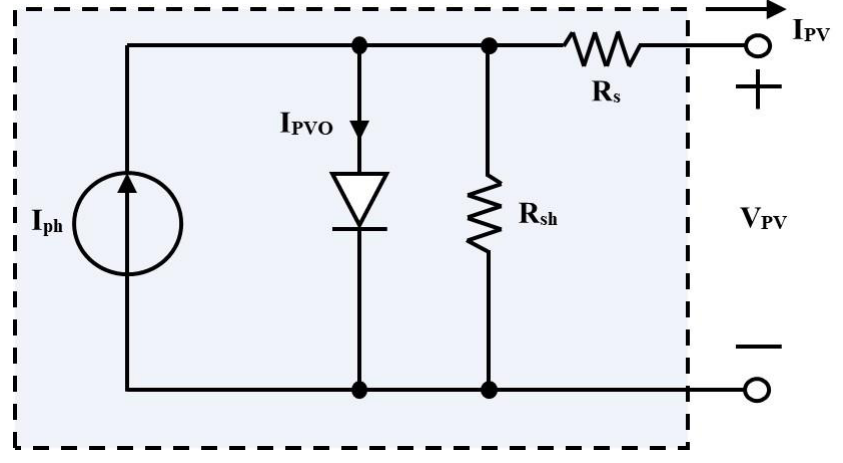
Figure 2. Single-diode PV cell equivalent circuit.